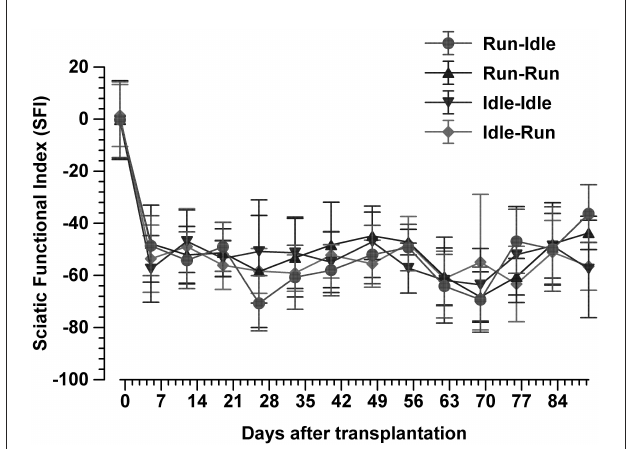
FIGURE3 Sciatic functional index. This synopsis of the SFI of 616 walking tracks of 32 Lewis rats demonstrates no functional recovery at all. In each group, the SFI drops sharply from the normal value of 0 immediately after the sciatic nerve transplant and does not recover during 91 days of regeneration (mean ± SD, n = 8 rats/groups).